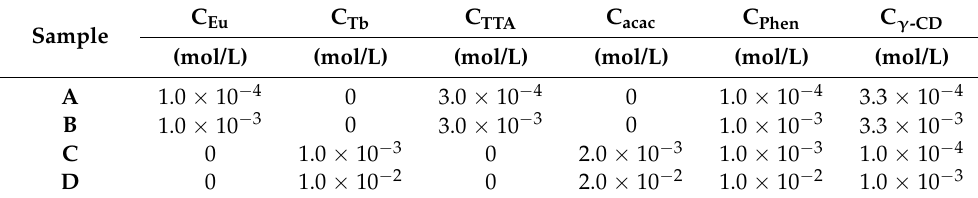
Table 1. Solution concentrations used to obtain ECA and